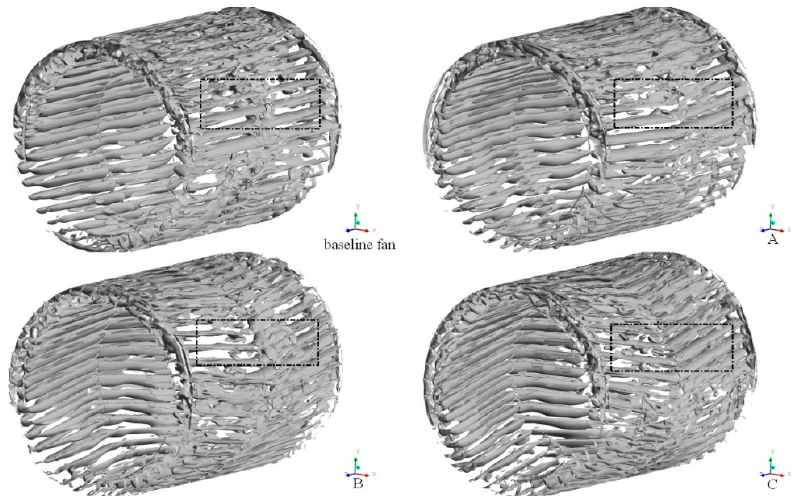
Figure 21. Three-dimensional distribution of vortices in impeller passages at Q / Q n = 0.483. ( B ) model-B; ( C )